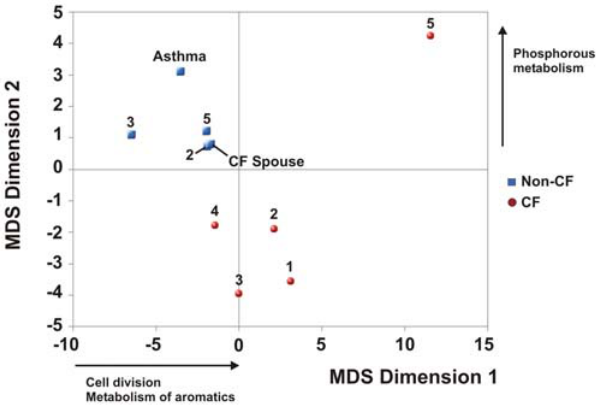
Figure 6. Non-metric multidimensional (NM-MDS) scaling of top-level SEED metabolic subsystems. All Non-CF metagenomes are shown in blue. CF1-5 are shown in red. The inputs to NM-MDS were the number of hits to subsystems in the highest level of the SEED hierarchy.